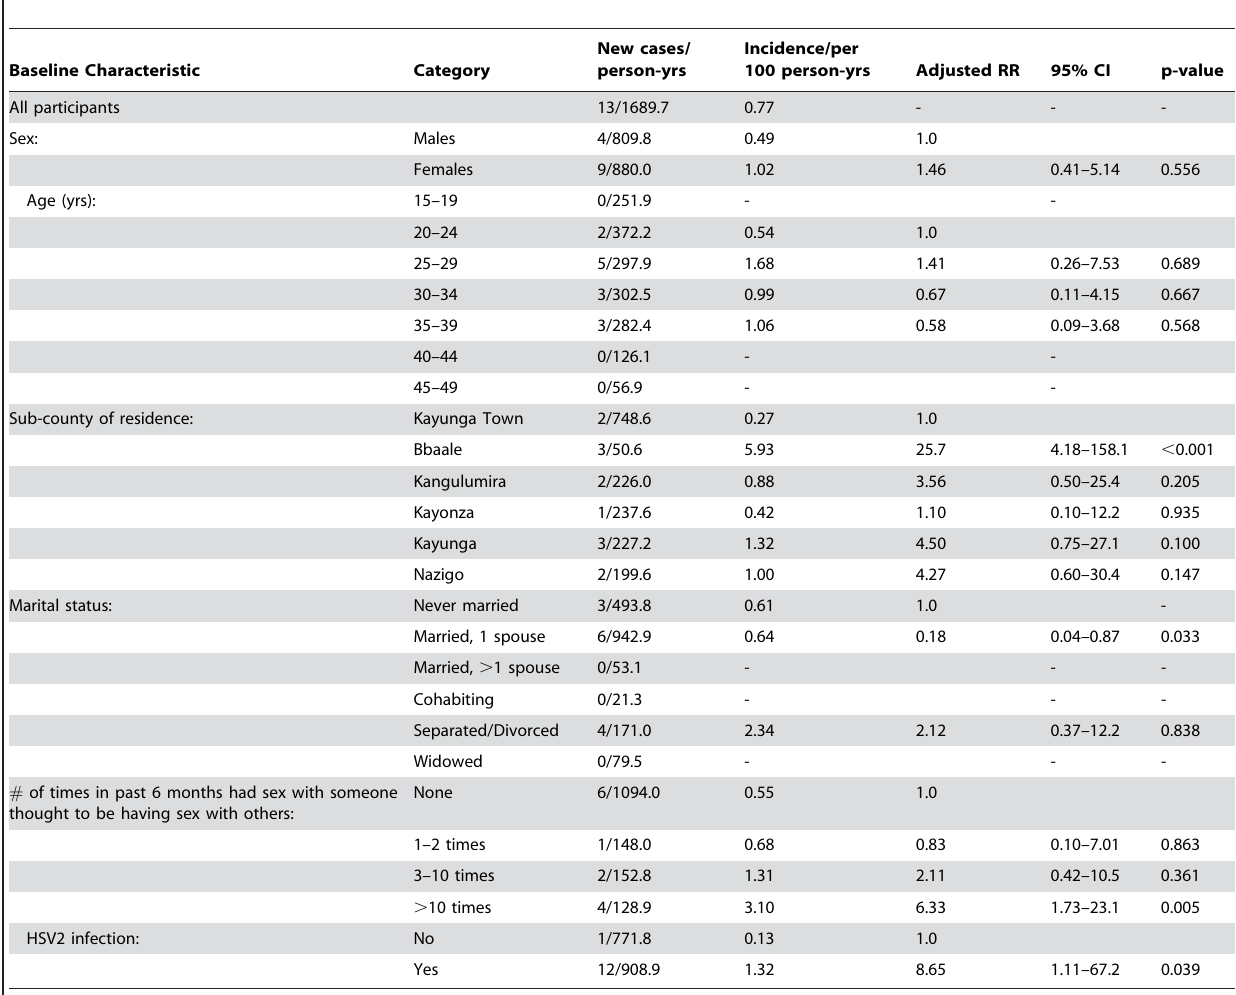
Table 3. Association between selected baseline factors to incident HIV infections.